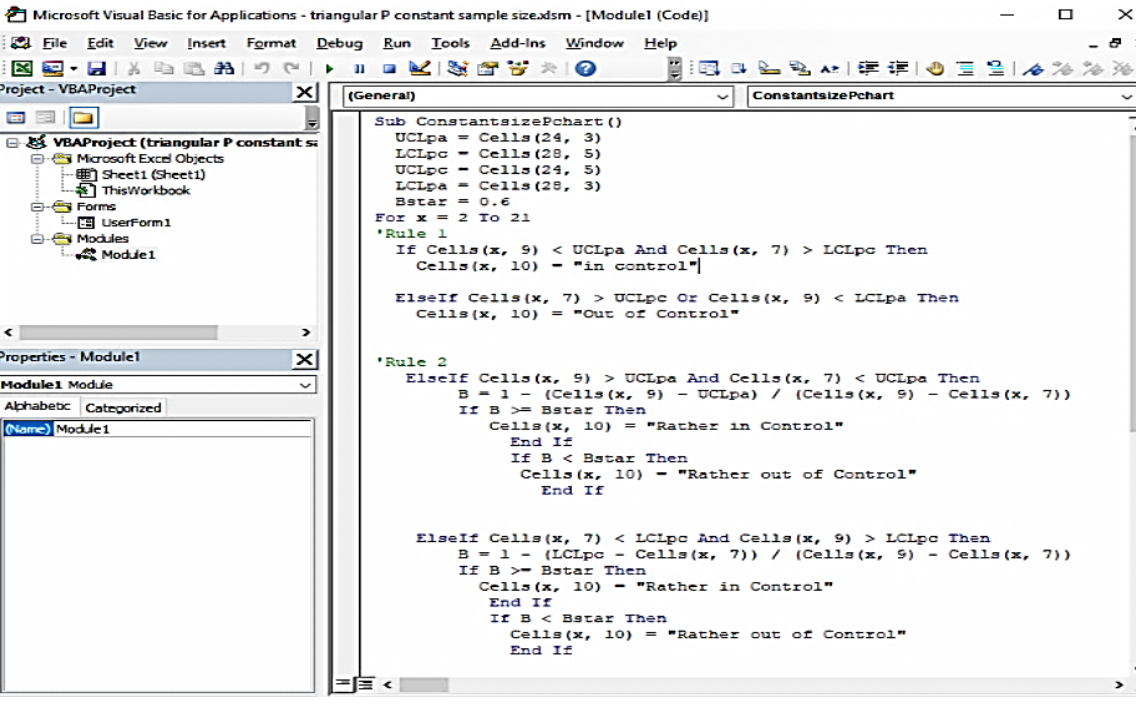
Figure 5. Visual Basic Coding for the Process Condition Algorithms (part